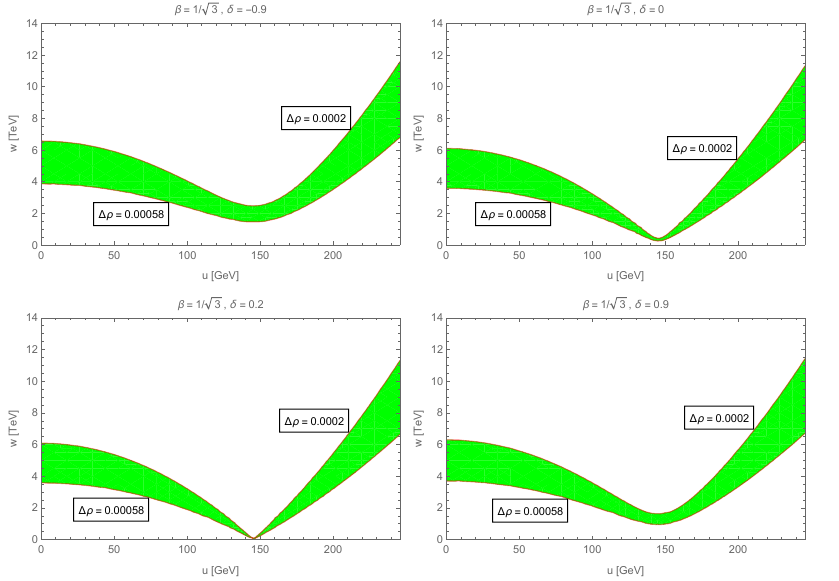
Figure 10 . The ( u, w ) regime constrained by ∆ ρ for β = 1 / √ 3, b = where the panels correspond to δ =